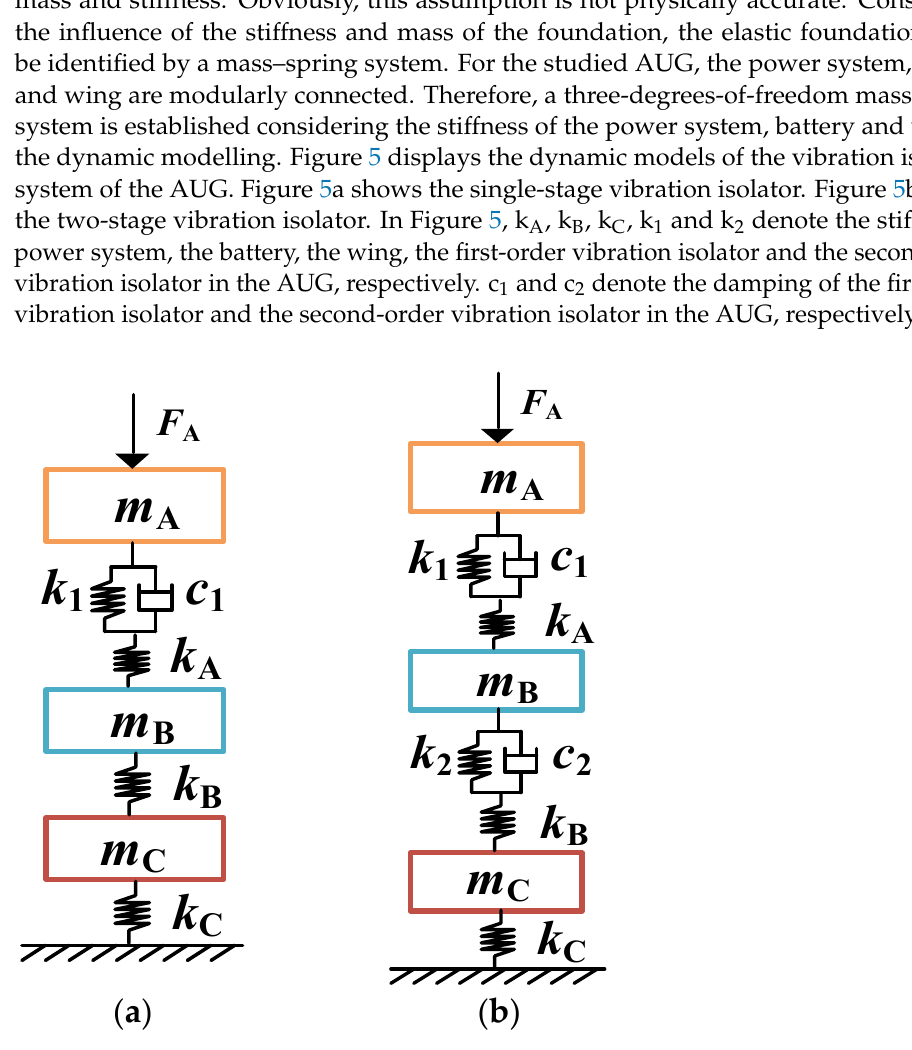
Figure 5. Dynamic models of the AUG with ( a ) the single-stage vibration isolator and ( b ) the two-stage vibration isolator.